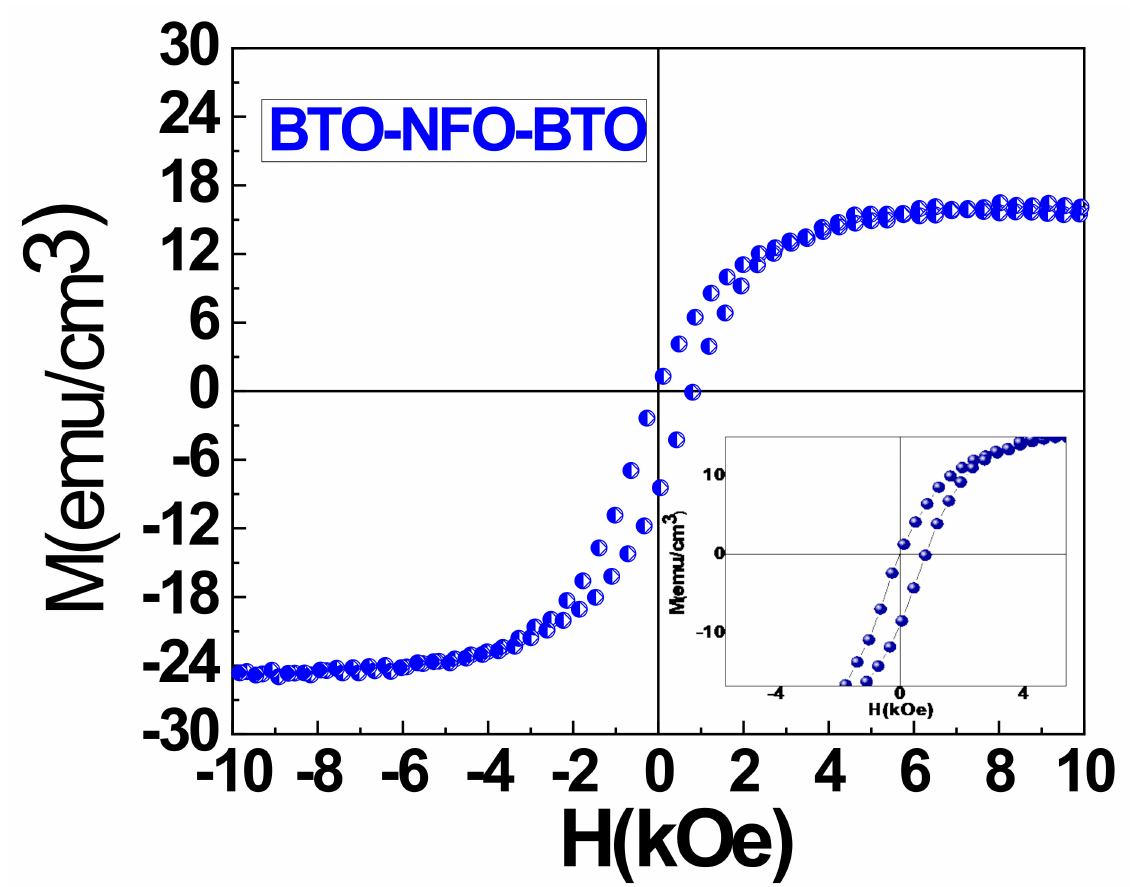
Figure 6. Magnetization-Electric Field Hysteresis loop of (BTO/NFO/BTO) tri-layered thin film deposited at room